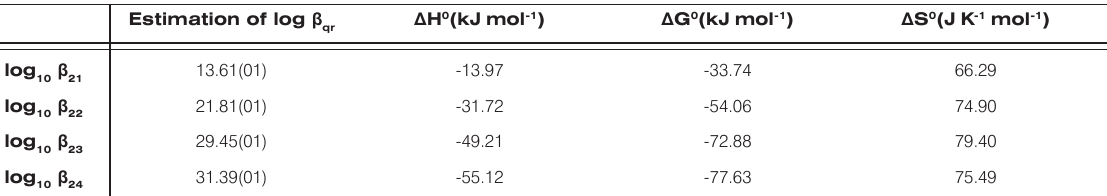
Estimation of log β